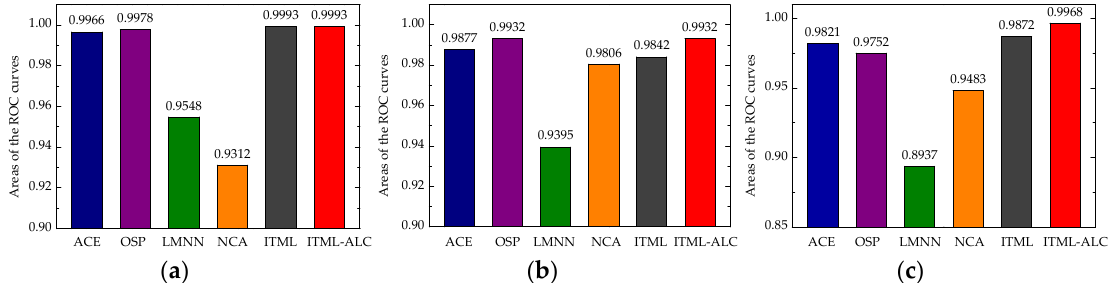
Figure 8. The AUCs of the different algorithms. ( a ) AVIRIS LCVF dataset; ( b ) AVIRIS San Diego airport dataset; ( c ) HYDICE urban dataset.